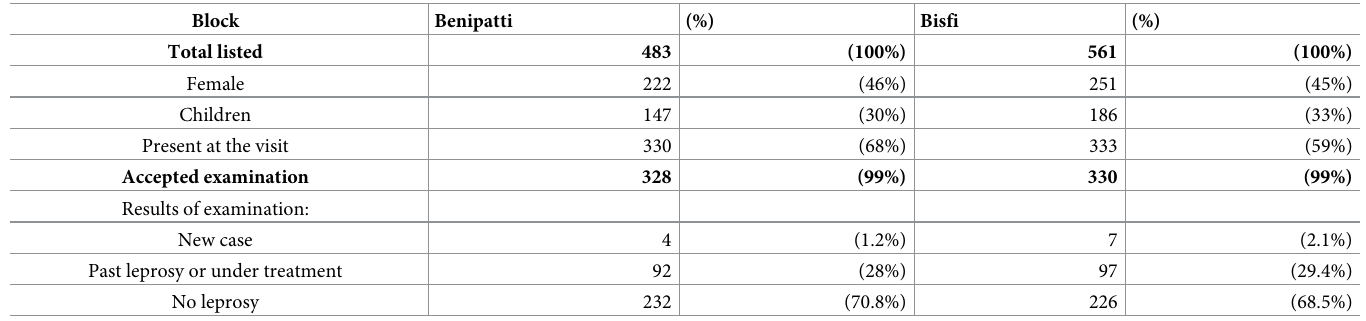
Table 4. Demographic characteristics and results of screening for leprosy among household contacts.